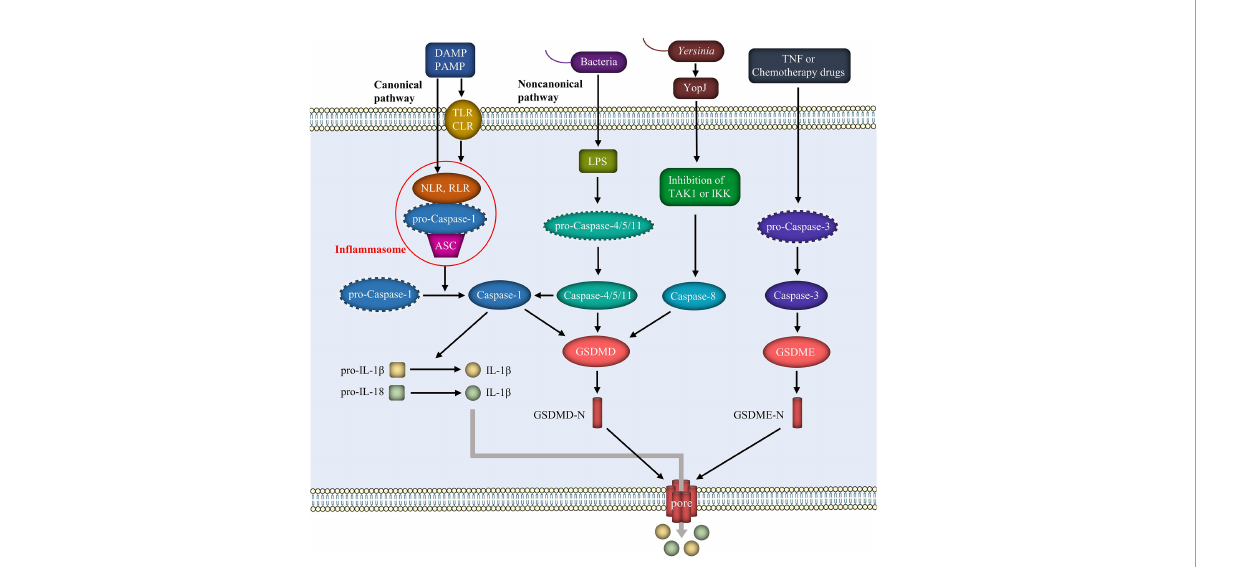
FIGURE 1 Mechanism of pyroptosis. The pathogenesis of pyroptosis includes mainly the canonical pathway mediated by the in fl ammasome and caspase- 1, the noncanonical pathway mediated by LPS and caspase-4/5/11, and some other pathways involving caspase-8 and caspase-3. These pathways result in the cleavage of GSDMD or GSDME and the separation of the N-terminal fragments. GSDMD-N or GSDME-N forms pores in the cell membrane, leading to the release of in fl ammatory factors such as IL-1 b and